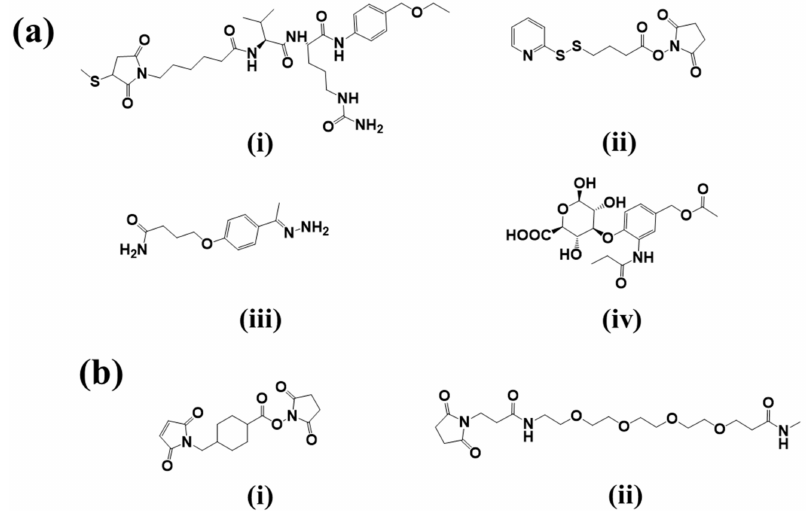
Figure 3. Chemical structures of linkers used in ADCs development. ( a ) Key cleavable linkers: (i) Lysosomal protease sensitive Val-Cit dipeptide linker; (ii) Glutathione sensitive SPDB linker; (iii) Acid Sensitive AcBut linker; and (iv) β -Glucuronidase sensitive linker; and ( b ) non-cleavable linkers: (i) SMCC linker; and (ii) PEG4Mal